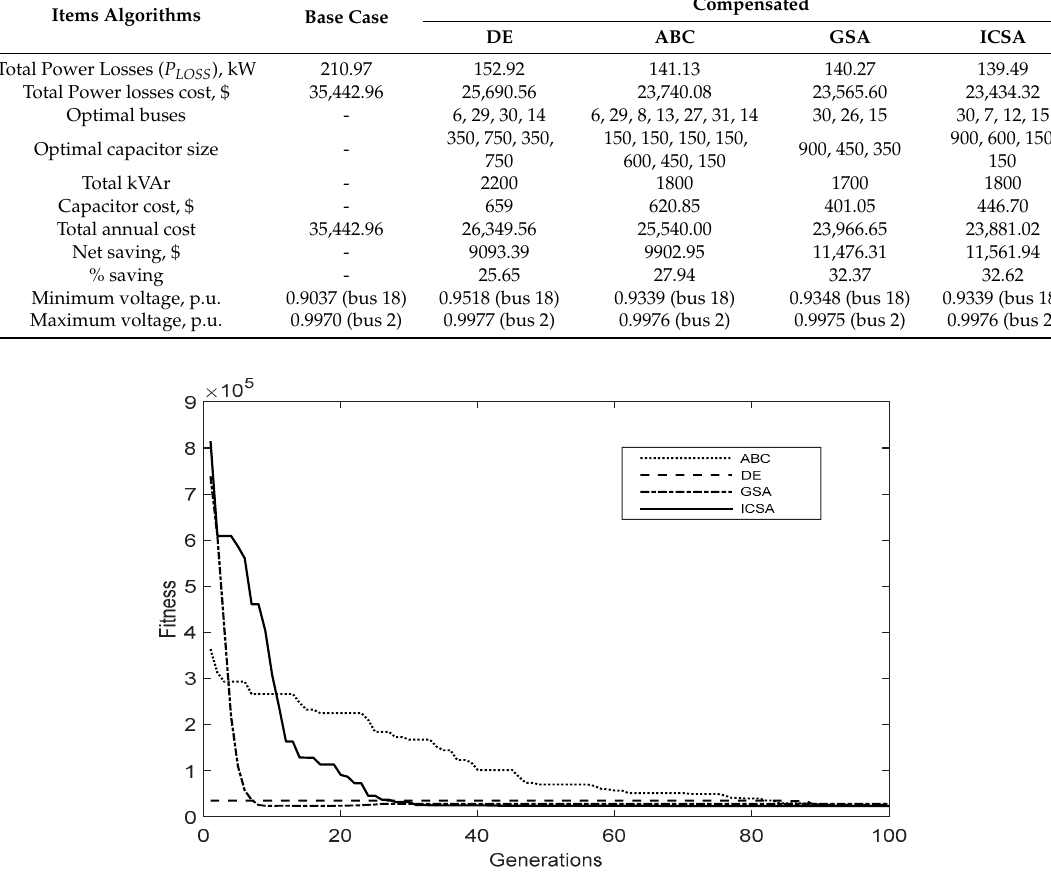
Table 12. Possible capacitor sizes and cost ($/kVAr).